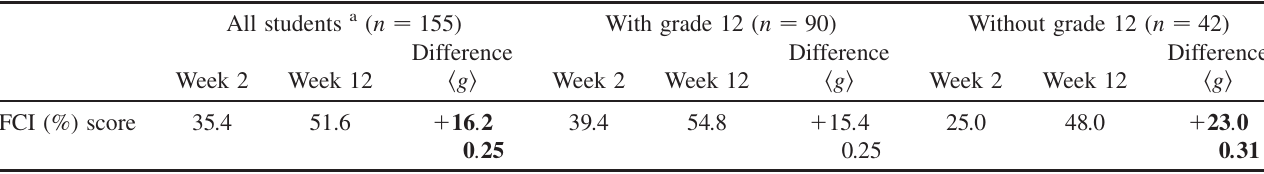
TABLE III. Pretest and posttest FCI scores, by grade 12 physics background. Differences that are statistically significant at the p < 0 : 05 level are shown in bold.